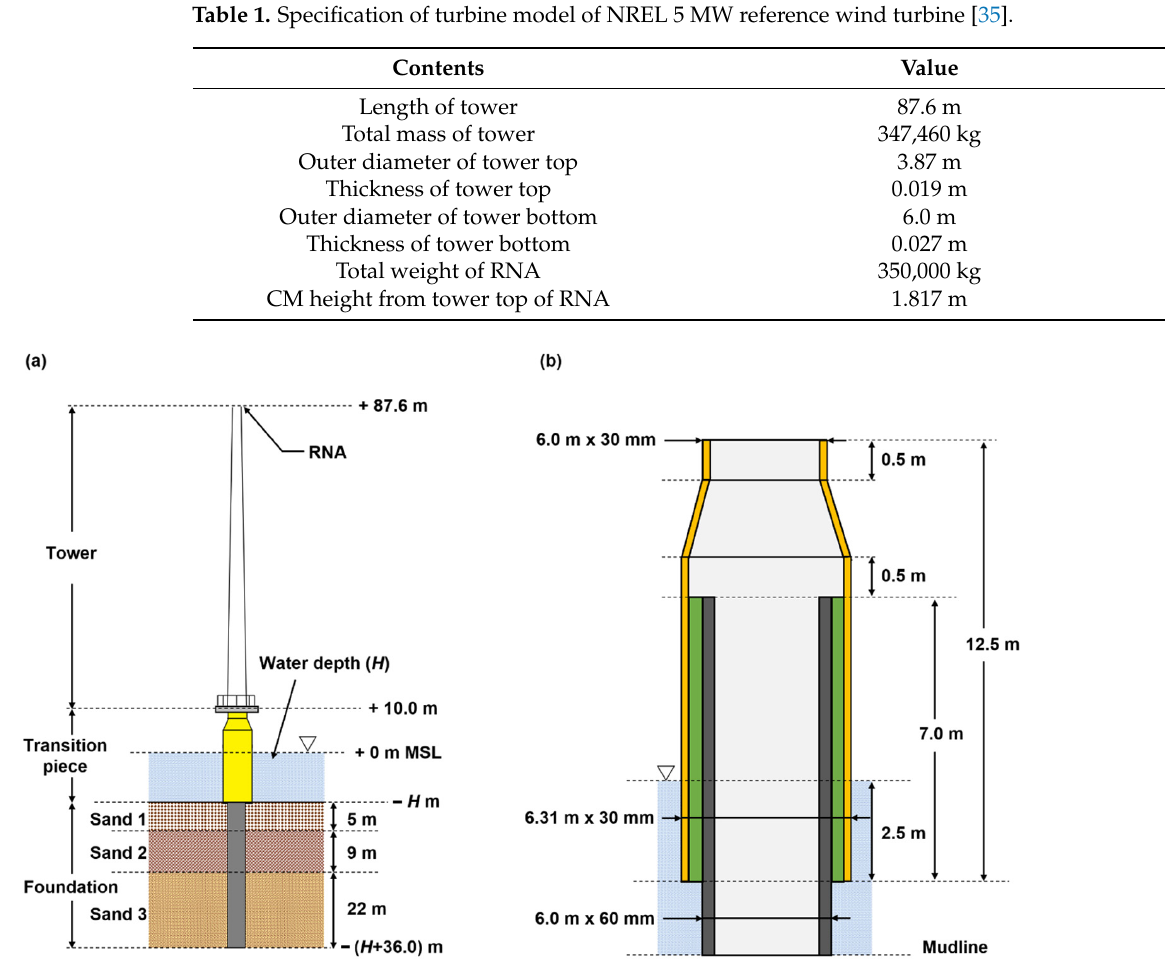
Figure 3. Dimensions of ( a ) NREL 5 MW and OC3 monopile embedded in layered sandy soil except for water depth and ( b ) detail of grouted connection. Table 1. Specification of turbine model of NREL 5 MW reference wind turbine [35].